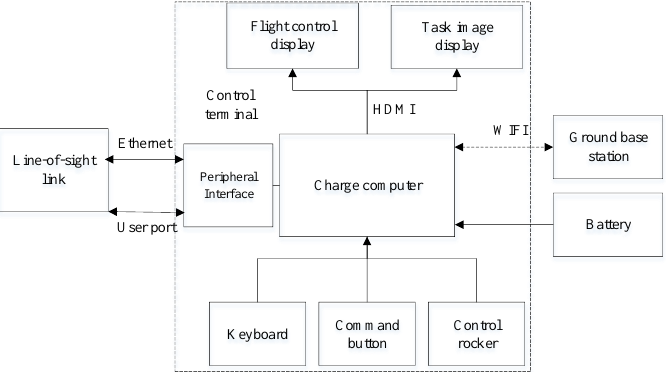
Figure 5. The main components and their relations of ground station